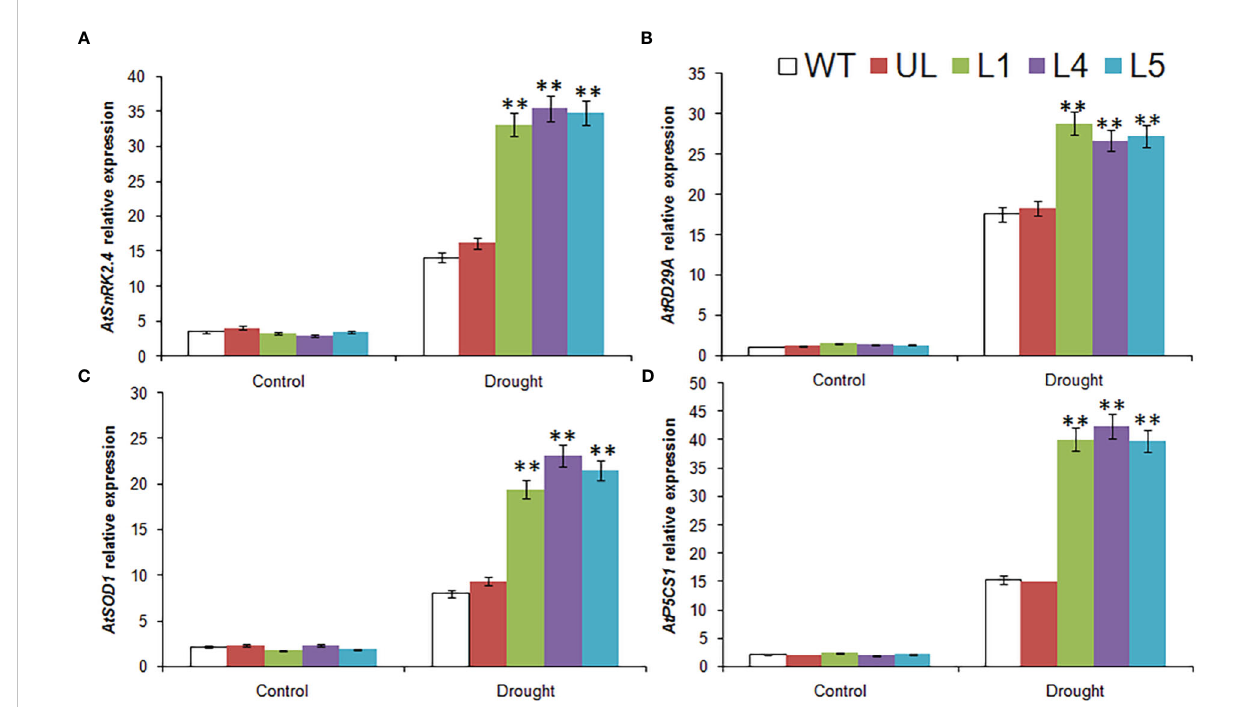
FIGURE 10 Expression of 4drought stress related genes in A. thaliana . The expression leave of (A) AtSnRK2.4 , (B) AtRD29A , (C) AtSOD1 and (D) AtP5CS1 . (**, P ≤ 0.01). The control was the index in the WT. All data were the average of 3